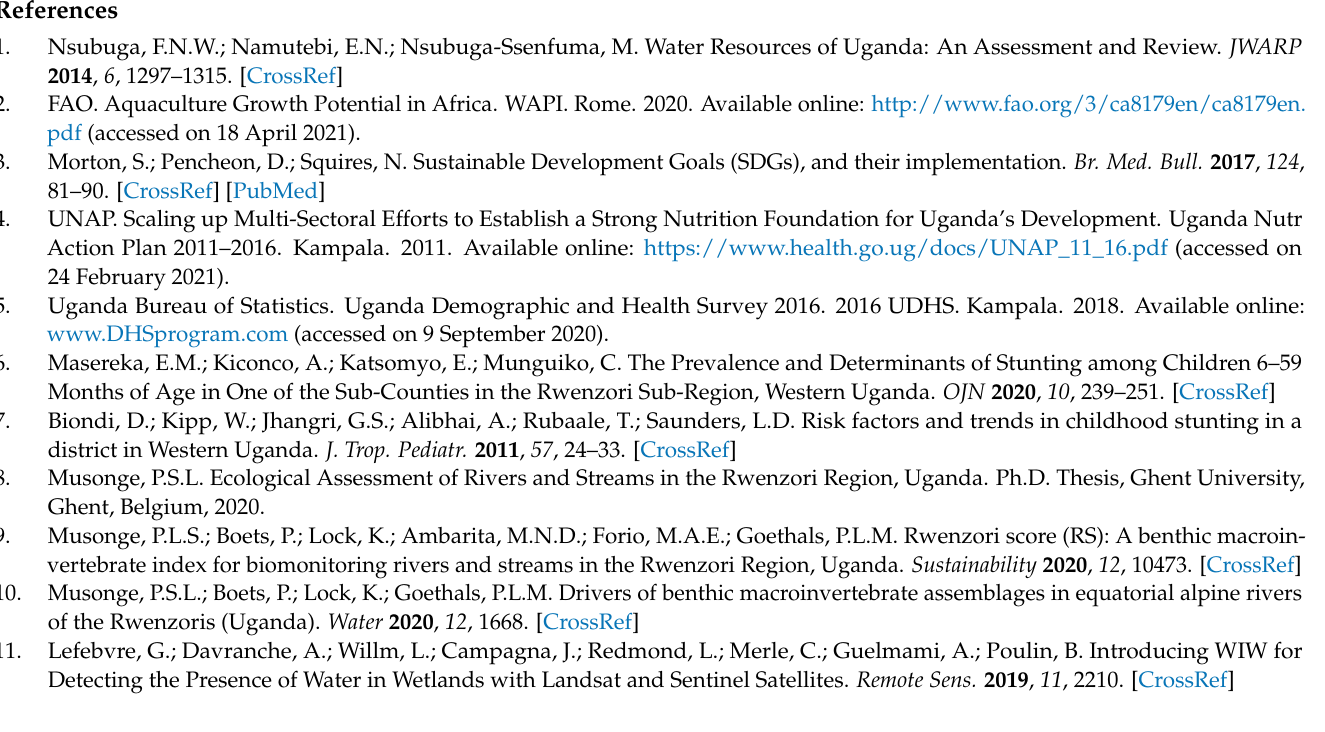
Figure S2: RGB images and the corresponding water maps of scene 2. Figure S3: RGB images, and the corresponding water maps of scene 3. Figure S4: RGB images and the corresponding water maps of scene 4. Figure S6: RGB images of the studied scenes (1, 2, 3, and 4) with the reference points (red) used for the accuracy analysis. Table S5: K-means cluster centers, where the optimum threshold (the center that gave the highest OA and kappa) is highlighted. Table S7: Confusion matrices of the water indices under the respective studied scenes of the Rwenzori region. Table S8: 39 extracted crater lakes by AWEI in scene 2 with their approximate area (m 2